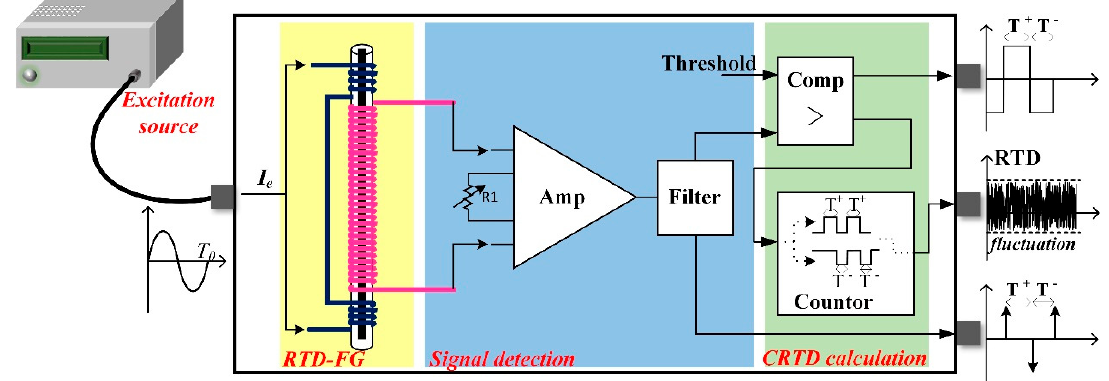
Figure 1. Block diagram of the traditional residence time difference (RTD) fluxgate sensor system and the working principle of the traditional RTD fluxgate system with the comparator RTD (CRTD) method.